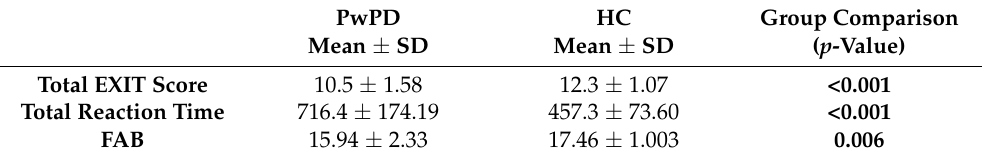
Table 3. Comparison of scores at EXIT 360 ◦